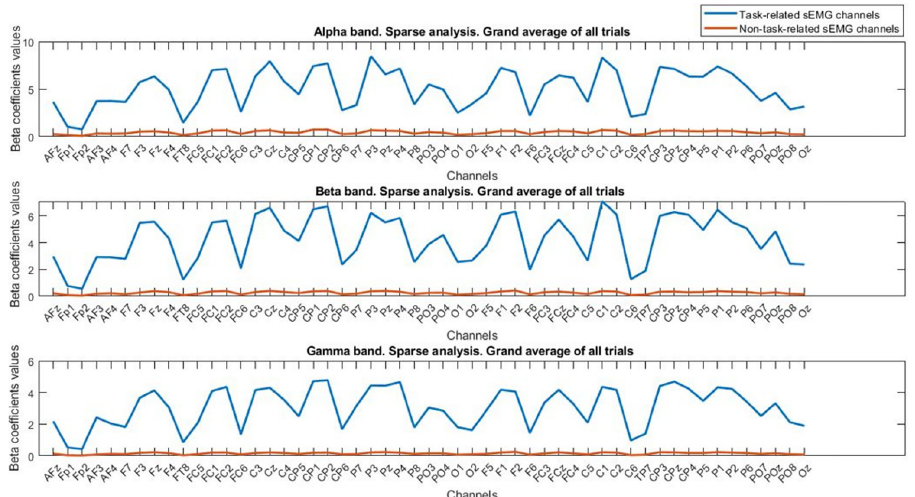
Fig 7. Grand average of sparse analysis results for different frequency bands. The stronger coupling values for the task-related sEMG channels are observable in all the 3 frequency ranges. The legend for all subplots is the same as row